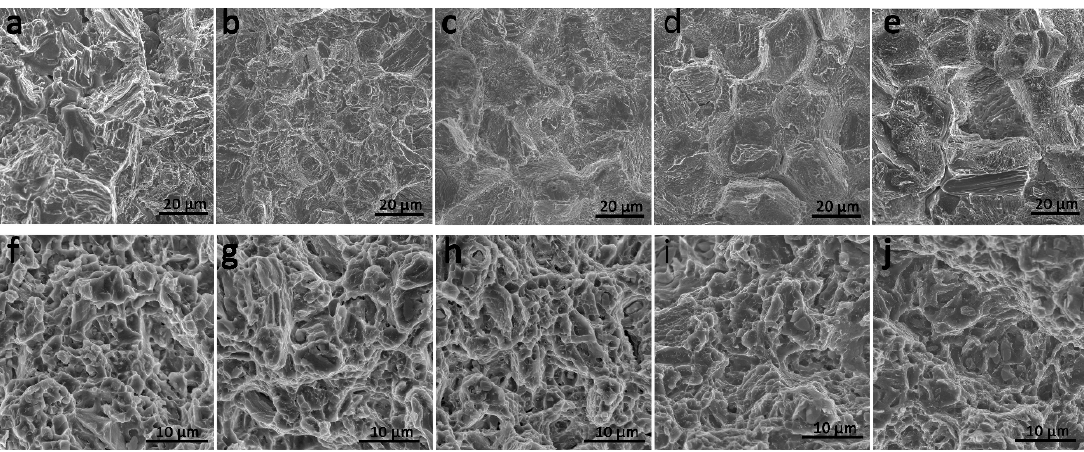
Figure 16. SEM fractographs of tensile tests of as-cast ( a – e ) and as-extruded ( f – j ) Mg–4Sm– x Zn–0.5Zr alloys at room temperature: ( a , f ) x = 0; ( b , g ) x = 1; ( c , h ) x = 2; ( d , i ) x = 3; ( e , j ) x = 4.